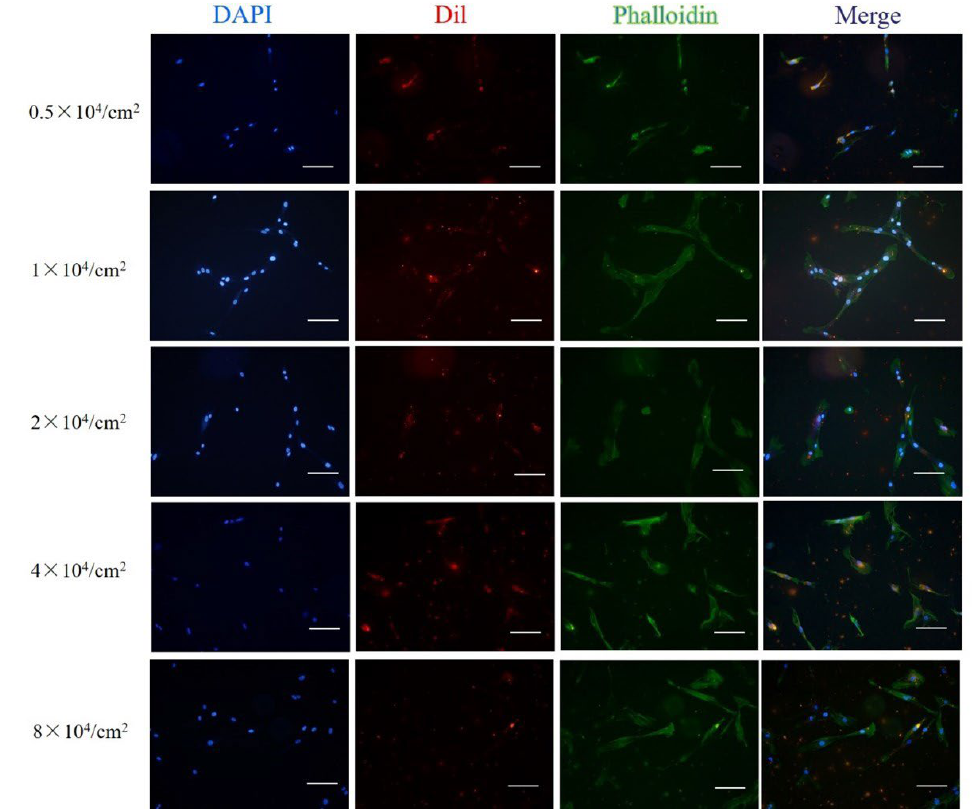
Figure 4. Uptake of secreted exosomes in hBMSCs from hPDLSCs with different initial cell culture densities, detected by fluorescence microscopy. Scale bar: 50 µm.